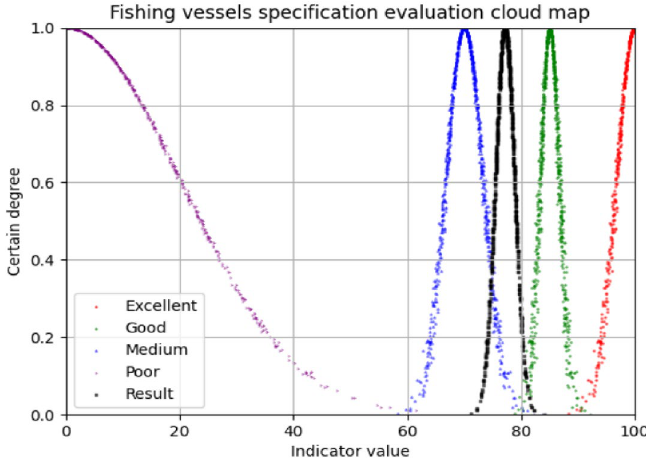
Figure 8. Fishing vessels specification evaluation cloud map.